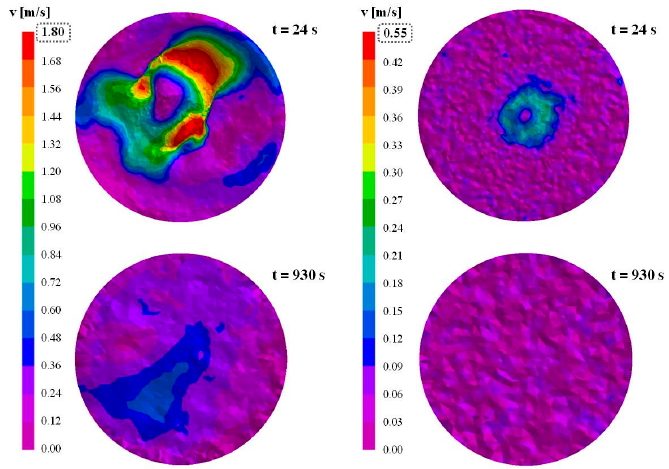
Figure 9. Tangential velocity at 24 and 930 s for the: complete model ( left ); and simplified model ( right ).